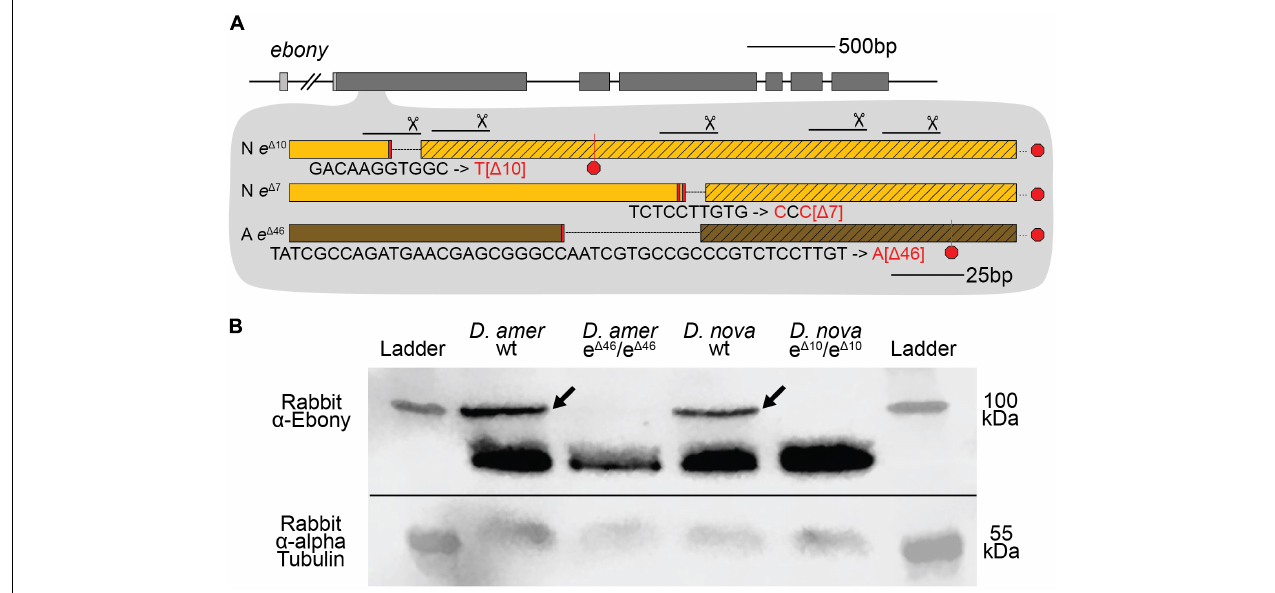
FIGURE 3 | CRISPR/Cas9-induced mutations created null alleles of the D. novamexicana and D. americana ebony genes. (A) A schematic of the ebony gene is shown with gray boxes indicating exons; coding sequence is indicated in the darker shade of gray. Locations of the five guide RNAs targeting the second exon of ebony are shown with solid lines below scissor symbols. Mutations observed in the two ebony mutants ( e (cid:49) 10 and e (cid:49) 7 ) isolated in D. novamexicana (“N”) and the one ebony mutant ( e (cid:49) 46 ) isolated in D. americana (“A”) are shown. All three alleles included deletions that caused frameshifts. (B) Western blotting showed that the D. americana e (cid:49) 46 and D. novamexicana e (cid:49) 10 mutants (lanes 2 and 4, respectively), lacked a ∼ 100 kDa protein (arrows) recognized by an antibody raised against D. melanogaster Ebony protein (Wittkopp et al., 2002) that is present in wild-type (wt) D. americana and D. novamexicana (lanes 1 and 3, respectively). Relative abundance of total protein loaded into each lane can be seen by the relative intensities of the shorter proteins also detected by the Ebony antibody (Wittkopp et al., 2002) as well as the relative intensities of ∼ 55 kDa bands detected by an antibody recognizing alpha Tubulin (Abcam ab52866). The solid black line shows where the membrane was cut prior to incubation with primary antibodies during the western blotting procedure; the top half was incubated with anti-Ebony antibodies whereas the bottom half was incubated with anti-Tubulin antibodies. The two halves were realigned by hand for imaging, using the shape of the cut and the ladder staining as a guide. An un-annotated image of this blot is shown in Supplementary Figure 4